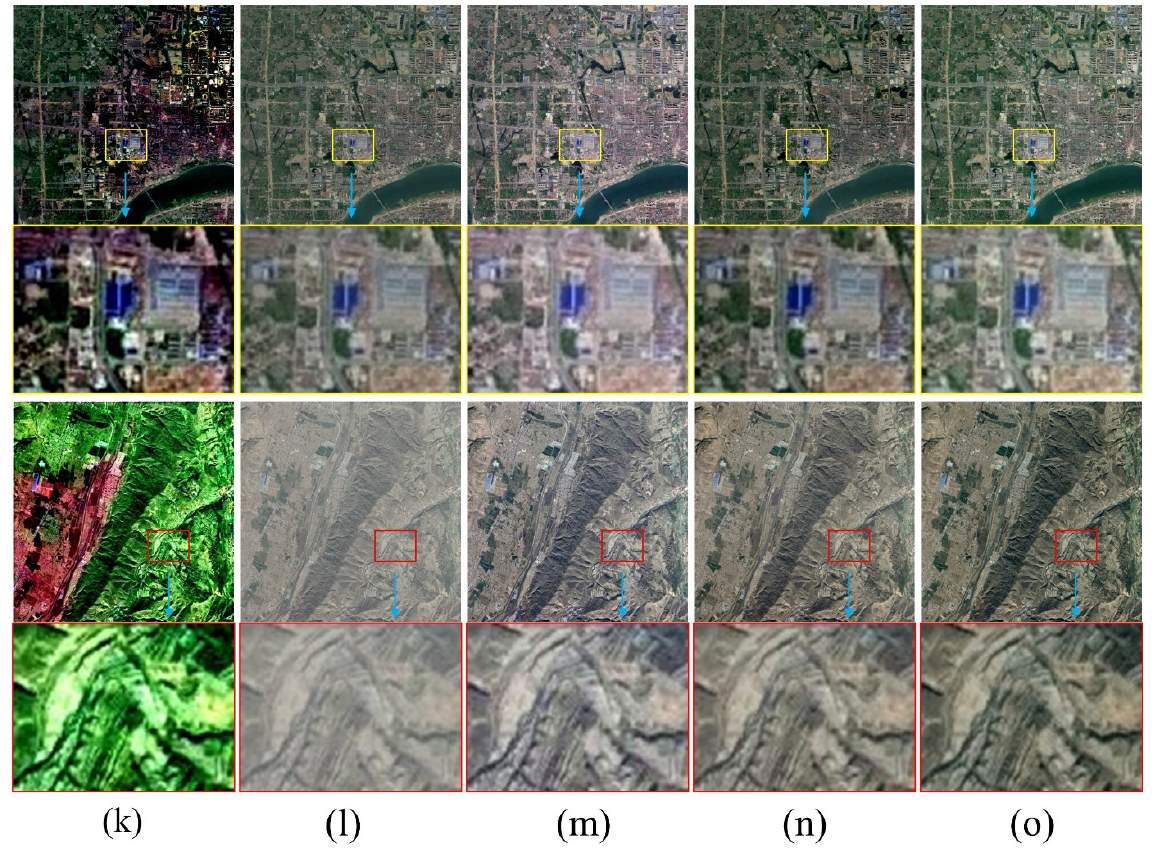
Figure 5. Comparisons with SOTA dehazing methods on the RICE-I dataset. ( a ) Hazy input image. ( b ) DCP. ( c ) MOF. ( d ) BCDP. ( e ) FFA. ( f ) EMRA. ( g ) LDN. ( h ) AESUN. ( i ) TBNN. ( j ) DDIP. ( k ) ZID. ( l ) YOLY. ( m ) ZIR. ( n ) Our method. ( o ) Ground truth. Table 3. Quantitative evaluation results for the RS uniform hazy dataset (RICE-I). The best value of the specific metric for each category is in